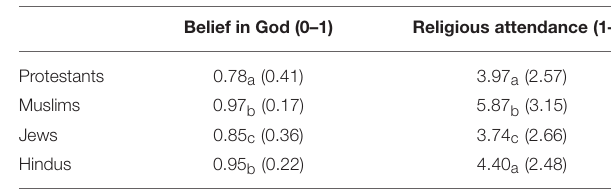
TABLE 3 | Belief in/importance of God and attendance of religious services, by religious group (Study